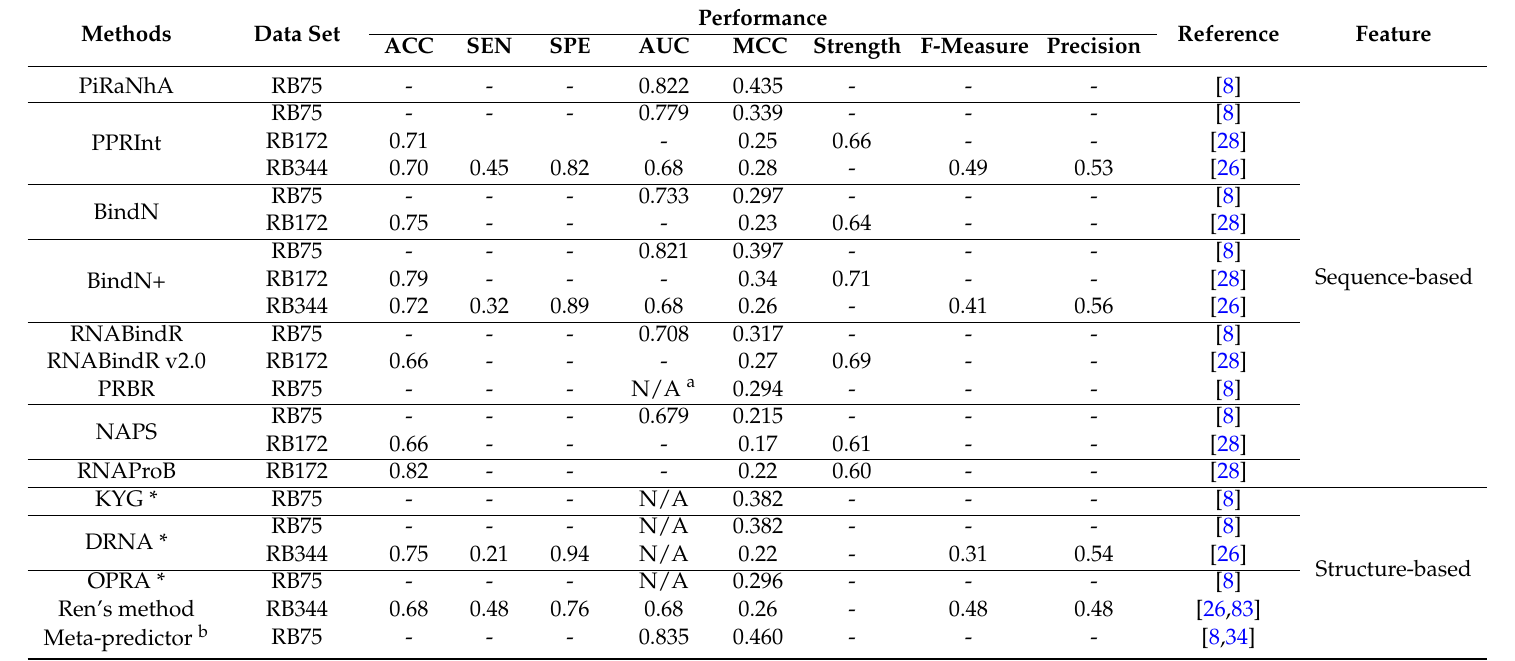
Table 4. Performance of the state-of-the-art methods for RNA-binding site